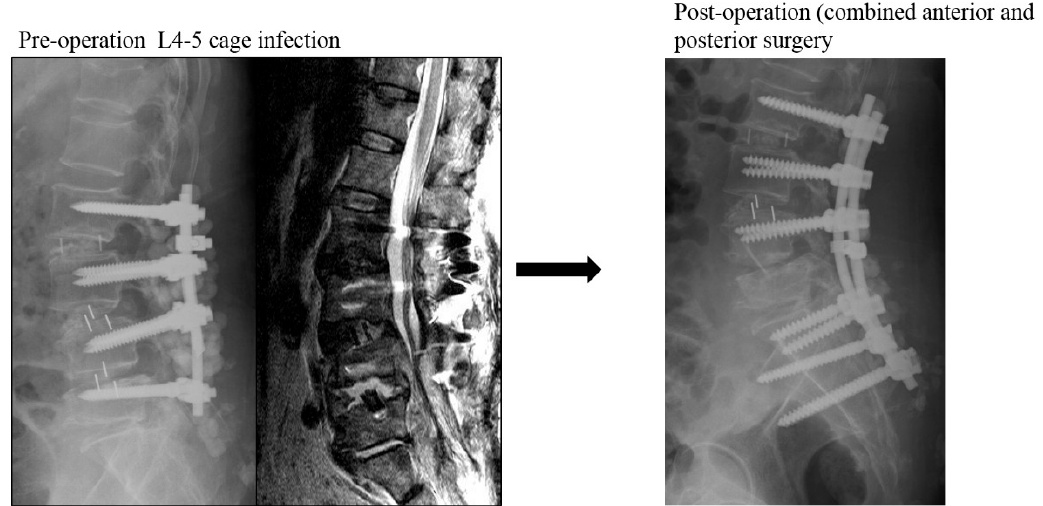
Figure 2. A case within the control group: L4-5 cage infection treated by anterior removal of cage and fusion, followed by posteriorly removal of L5 and extending instrumentation to S1 and ilium.